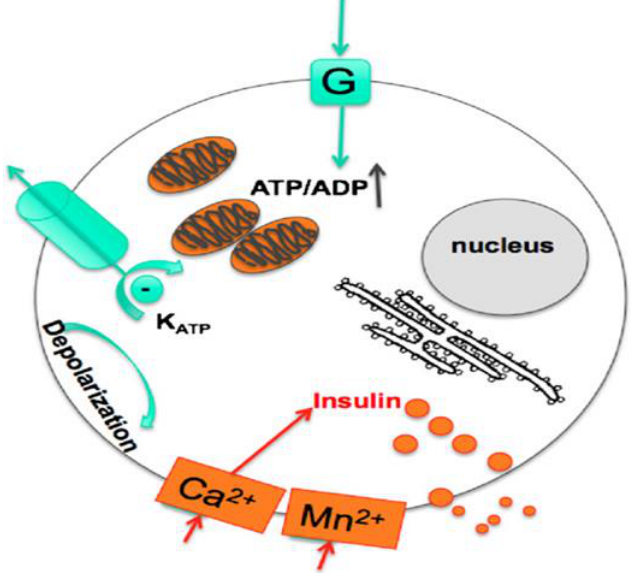
Figure 8. Glucose-dependent Ca 2+ channels participate in the entry of Mn 2+ into β-cells through these channels [156].